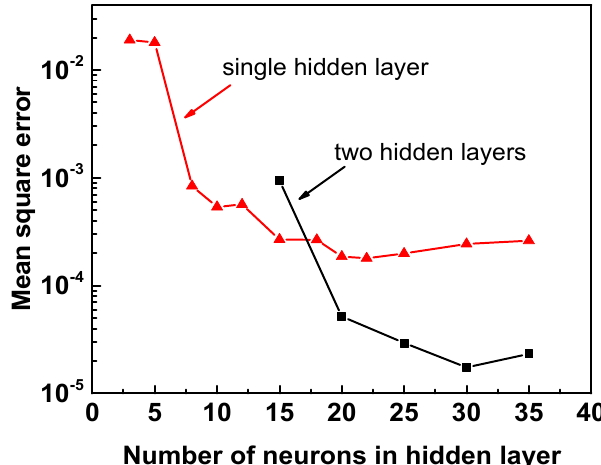
Figure 5. Dependence of mean square error and number of layers and neurons in hidden layer.